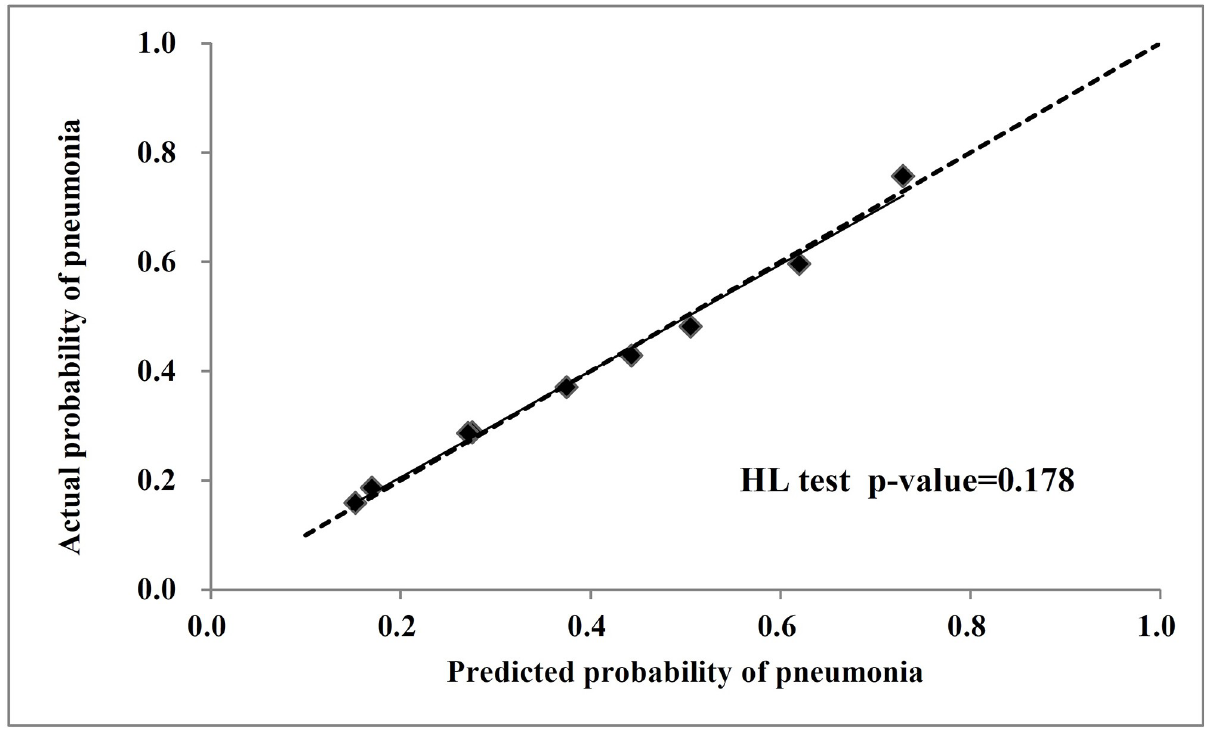
Fig 2. The calibration curve for the radiomics nomogram plot. Dashed line indicates ideal reference line where predicted probabilities would match the observed proportions (the diagonal square) and, of which a closer fit to the diagonal dotted line represents a better prediction. The Hosmer- Lemeshow test showed the p-value is